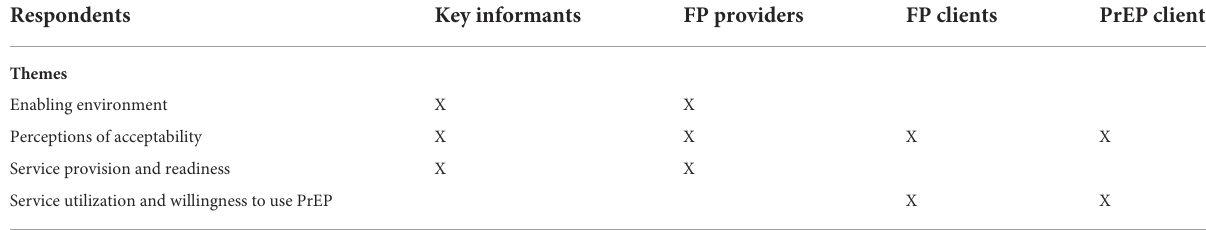
TABLE 1 Themes explored (by participant